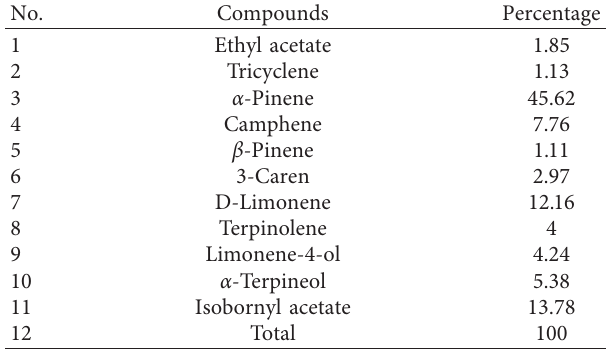
Table 8: Chemical composition of the essential oil from the Pistacia vera L.